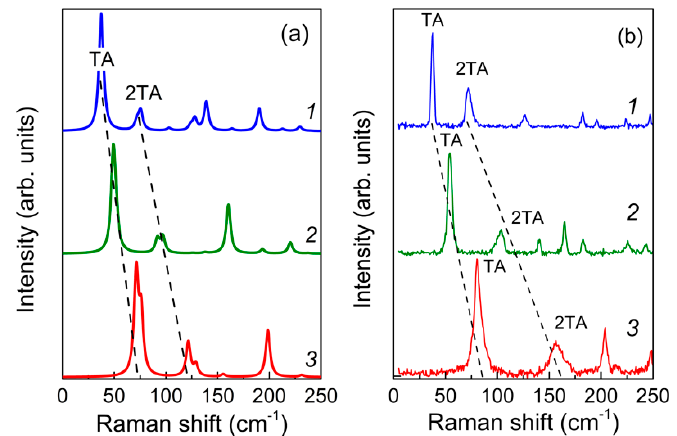
Figure 4. The low-frequency parts of the calculated ( a ) and experimental ( b ) Raman spectra in the x(yz)x scattering geometry for the (GaN) m /(AlN) n SLs with m / n = 8/8 ( 1 ), 6/6 ( 2 ), and 4/4 ( 3 ). It can be seen that in calculations and experiments, the line positions noticeably